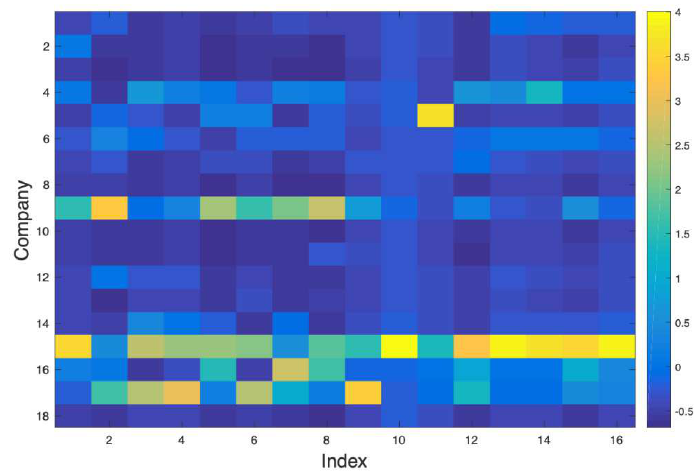
Figure 2. Heat-map of the Z’ matrix (second